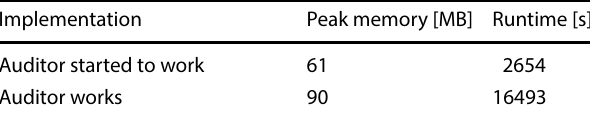
Table 4 The effect of changing what x means Implementation